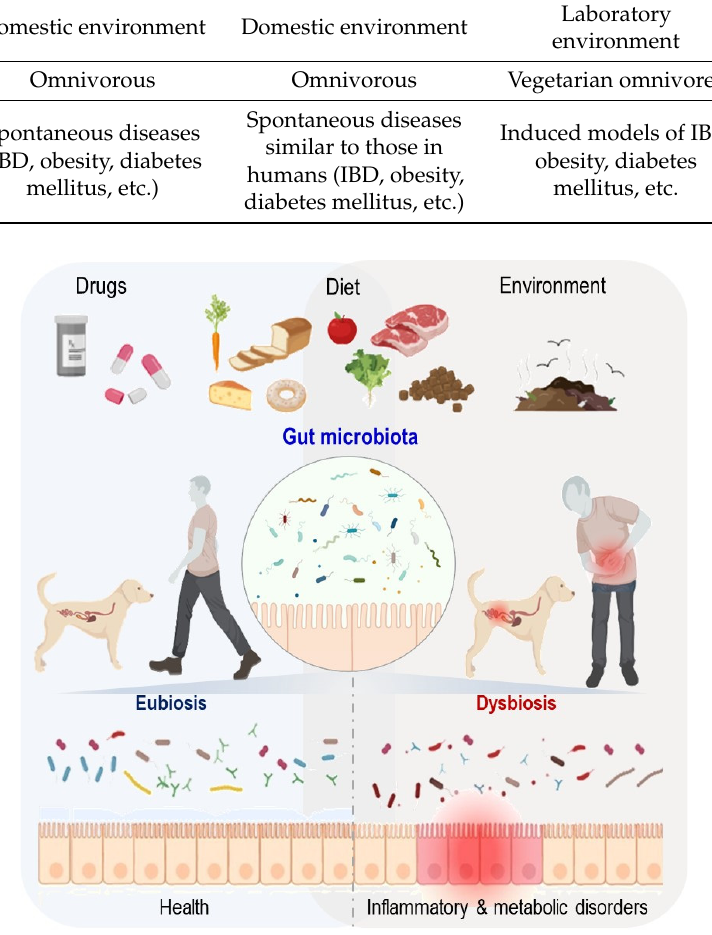
Figure 1. Overview of the impact of the domestic environment on the gut microbiota and health of humans and pet dogs.